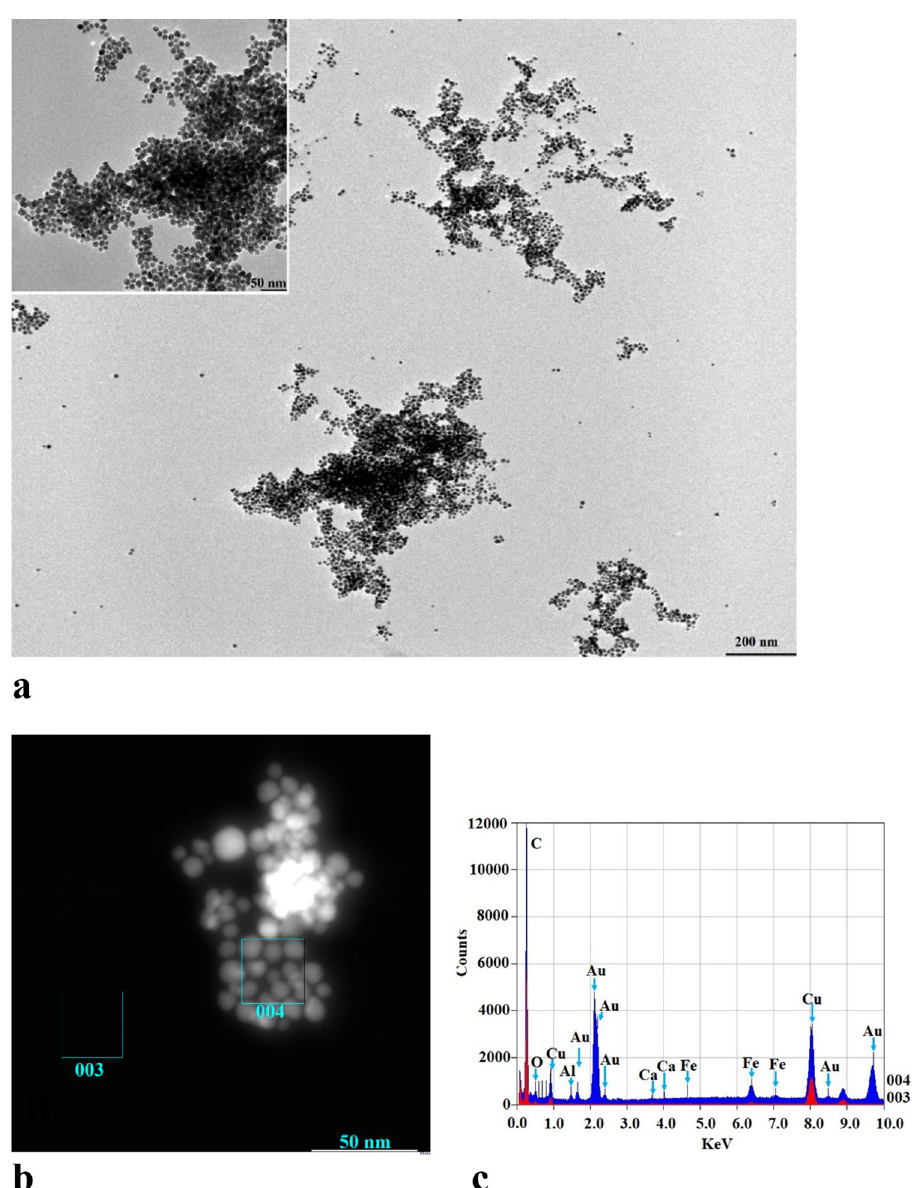
Figure 2. Detection of AuNPs by electron microscopy. ( a ) TEM-obtained image (scale bar = 200 nm and insert photo scale bar = 50 nm), ( b ) representative detail of areas 003 and 004 used for subsequent EDS analysis (scale bar = 50 nm), and ( c ) the EDS spectra overlay of the gated areas with marked blue and red peaks representing individual elements in the areas 004 and 003, respectively.